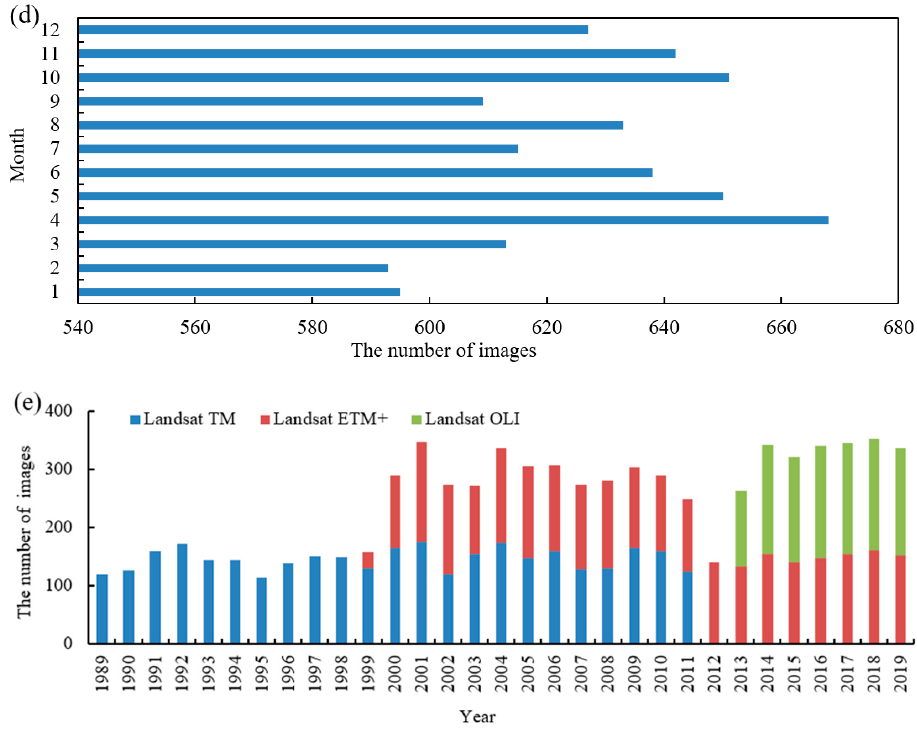
Figure 2. Landsat images of the study area from 1989 to 2019: ( a ) Spatial distribution of the number of all Landsat images; ( b ) spatial distribution of the number of high-quality Landsat images; ( c ) spatial distribution of the number of Landsat images in each map; ( d ) seasonal distribution of the number of Landsat images; ( e ) the number of images obtained from different Landsat sensors.